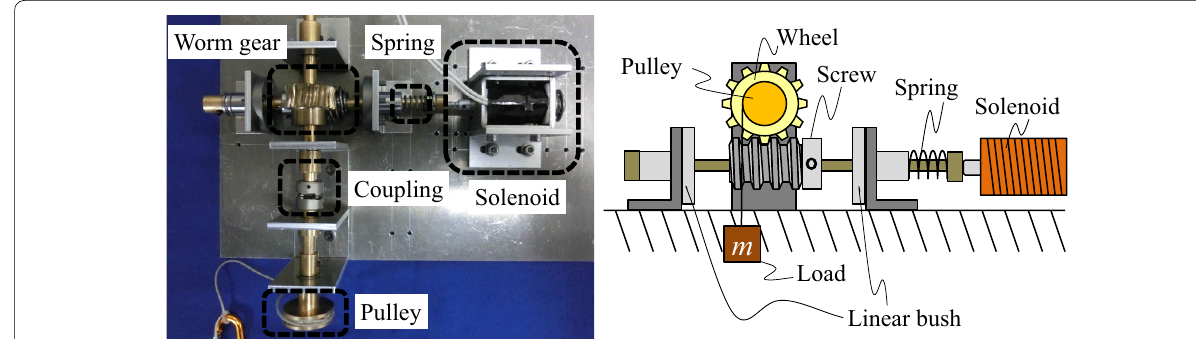
Fig. 5 Experimental setup to observe the backdrivability when the worm screw is vibrated